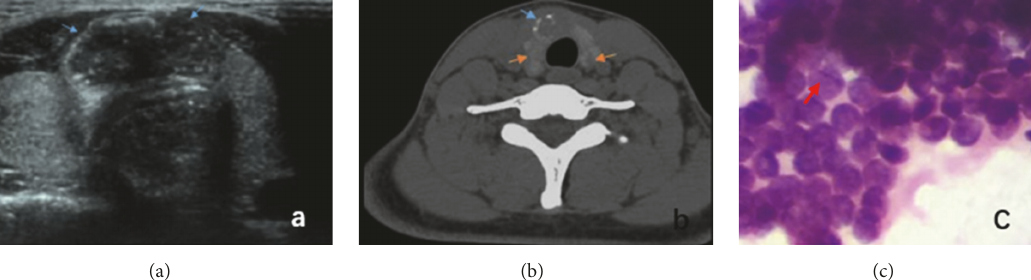
Figure 1: (a) B Ultrasound . Blue arrow for the low echo tubercle in the thyroid isthmus. (b) CT Scan . Yellow arrow for thyroid multiple lower density nodule; blue arrow for calcification. (c) FNA . Red arrow for cell nucleus ditch.